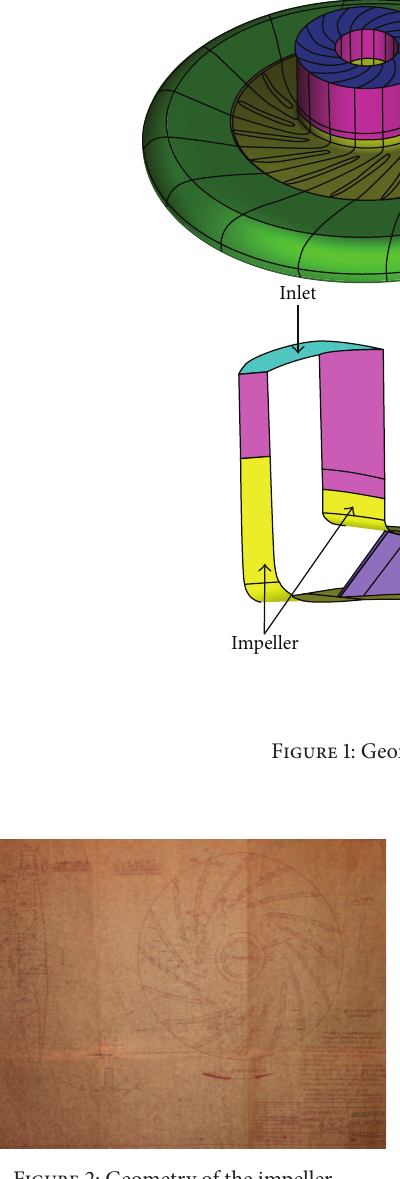
Figure 2: Geometry of the impeller.